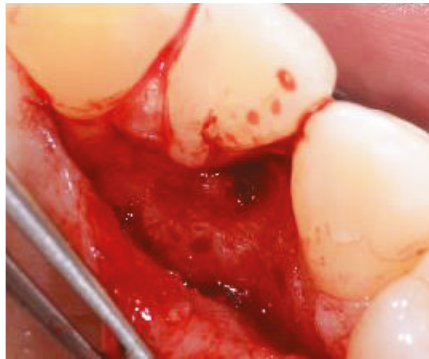
Figure 7: The bone substitute was placed in the osseous defect after it had been conditioned through a 24% EDTA gel and irrigated with abundant sterile saline solution.